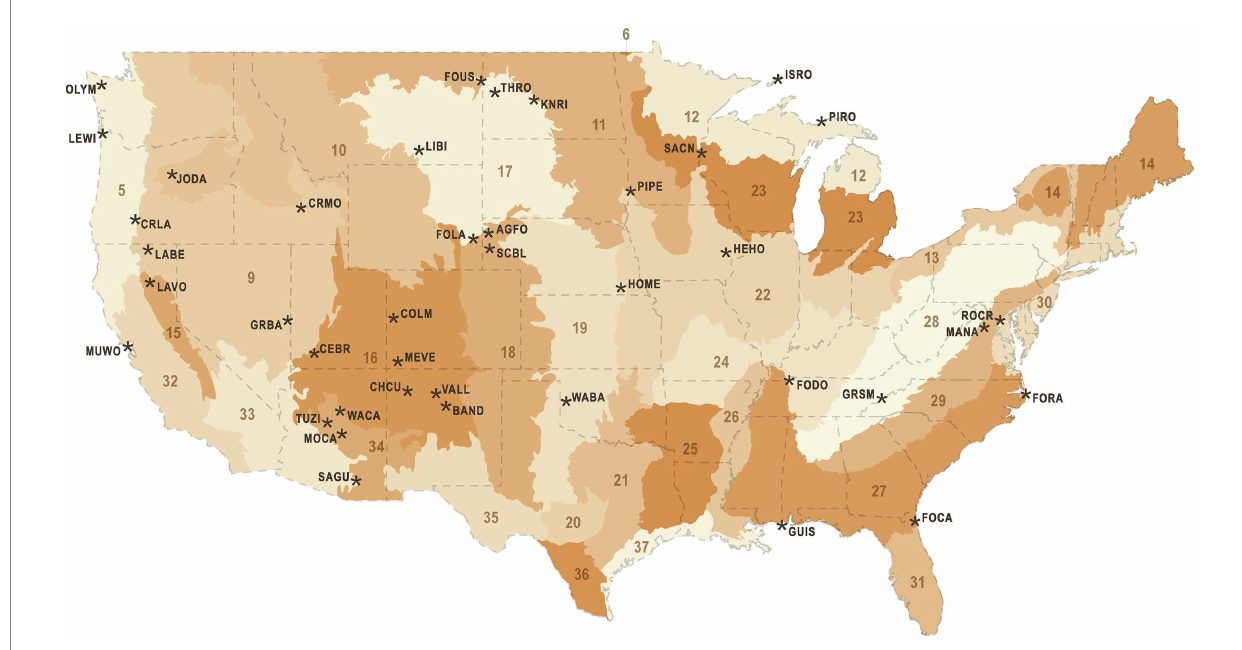
FIGURE 1 National Park units (black text and asterisks) and Bird Conservation Regions (numbered, shaded areas). National Park unit abbreviations are Agate Fossil Beds National Monument (AGFO), Bandelier National Monument (BAND), Cedar Breaks National Monument (CEBR), Chaco Culture National Historical Park (CHCU), Colorado National Monument (COLM), Crater Lake National Park (CRLA), Craters of the Moon National Monument (CRMO), Fort Caroline National Memorial (FOCA), Fort Donelson National Battlefield (FODO), Fort Laramie National Historic Site (FOLA), Fort Raleigh National Historic Site (FORA), Fort Union Trading Post National Historic Site (FOUS), Great Basin National Park (GRBA), Great Smoky Mountains National Park (GRSM), Gulf Islands National Seashore (GUIS), Herbert Hoover National Historic Site (HEHO), Homestead National Monument of America (HOME), Isle Royale National Park (ISRO), John Day Fossil Beds National Monument (JODA), Knife River Indian Villages National Historic Site (KNRI), Lava Beds National Monument (LABE), Lassen Volcanic National Park (LAVO), Lewis and Clark National Historical Park (LEWI), Little Bighorn Battlefield National Monument (LIBI), Manassas National Battlefield Park (MANA), Mesa Verde National Park (MEVE), Montezuma Castle National Monument (MOCA), Muir Woods National Monument (MUWO), Olympic National Park (OLYM), Pipestone National Monument (PIPE), Pictured Rocks National Lakeshore (PIRO), Rock Creek Park (ROCR), Saint Croix/Lower St. Croix National Scenic River (SACN), Saguaro National Park (SAGU), Scotts Bluff National Monument (SCBL), Theodore Roosevelt National Park (THRO), Tuzigoot National Monument (TUZI), Valles Caldera National Preserve (VALL), Washita Battlefield National Historic Site (WABA), Walnut Canyon National Monument (WACA). Bird Conservation Region numbers are Northern Pacific Rainforest (5), Boreal Taiga Plains (6), Great Basin (9), Northern Rockies (10), Prairie Potholes (11), Boreal Hardwood Transition (12), Lower Great Lakes/ St. Lawrence Plain (13), Atlantic Northern Forest (14), Sierra Nevada (15), Southern Rockies/Colorado Plateau (16), Badlands And Prairies (17), Shortgrass Prairie (18), Central Mixed Grass Prairie (19), Edwards Plateau (20), Oaks And Prairies (21), Eastern Tallgrass Prairie (22), Prairie Hardwood Transition (23), Central Hardwoods (24), West Gulf Coastal Plain/Ouachitas (25), Mississippi Alluvial Valley (26), Southeastern Coastal Plain (27), Appalachian Mountains (28), Piedmont (29), New England/Mid-Atlantic Coast (30), Peninsular Florida (31), Coastal California (32), Sonoran And Mojave Deserts (33), Sierra Madre Occidental (34), Chihuahuan Desert (35), Tamaulipan Brushlands (36), Gulf Coastal Prairie